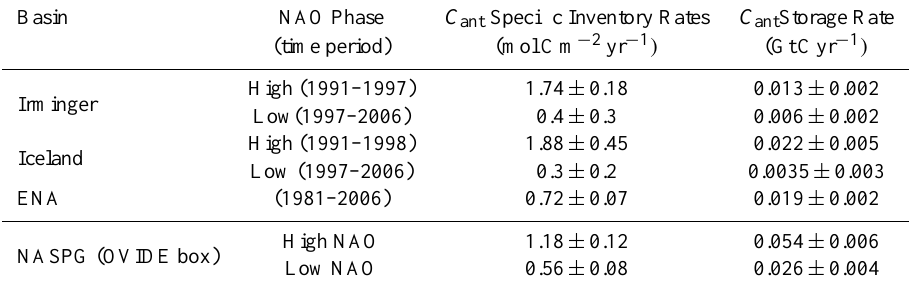
Table 3. The C ant storage rates ± standard error of the estimate for different NAO phases in the considered NASPG basins. The high NAO phase extends from 1989 to 1995 and the low NAO phase from 1996 to 2006. No cruise data for either 1989 or 1996 was available, therefore, data from the closest available years (1990/91 and 1997) was used for storage rate calculations for the high NAO phase (Fig. 3). In the Iceland basin the high NAO interval was further extended to 1998 for storage rate calculation purposes alone, given the shortage of data.